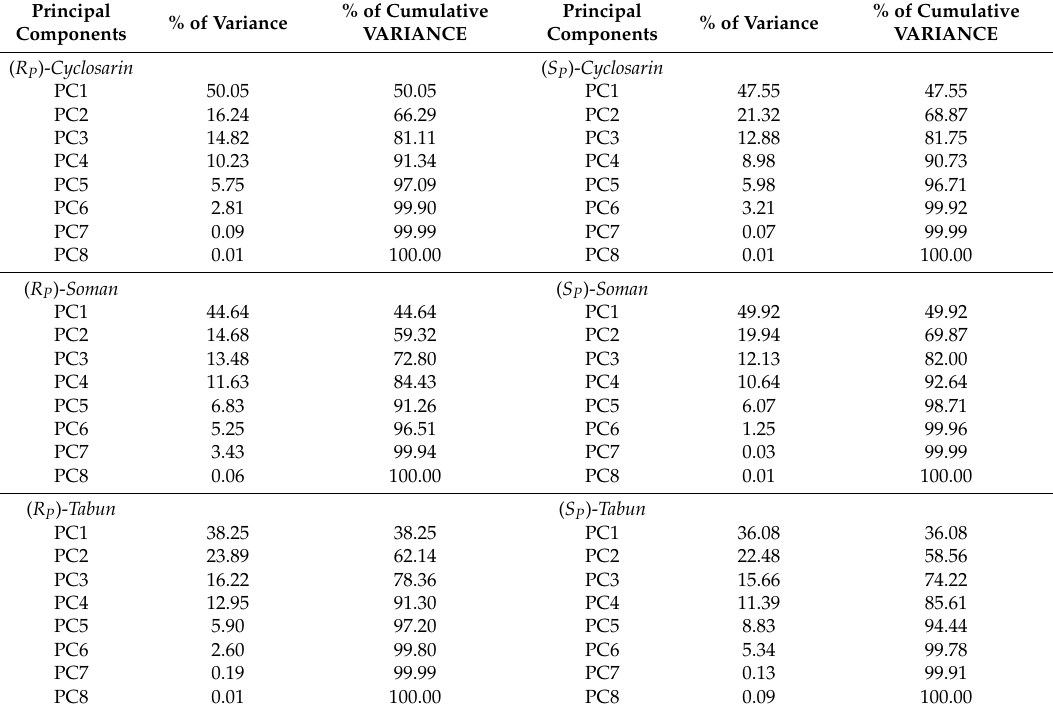
Table 1. Percentage of variance of the data explained by PCA for the OP and their enantiomers. Principal % of Cumulative Principal % of % of Variance VARIANCE Components Components